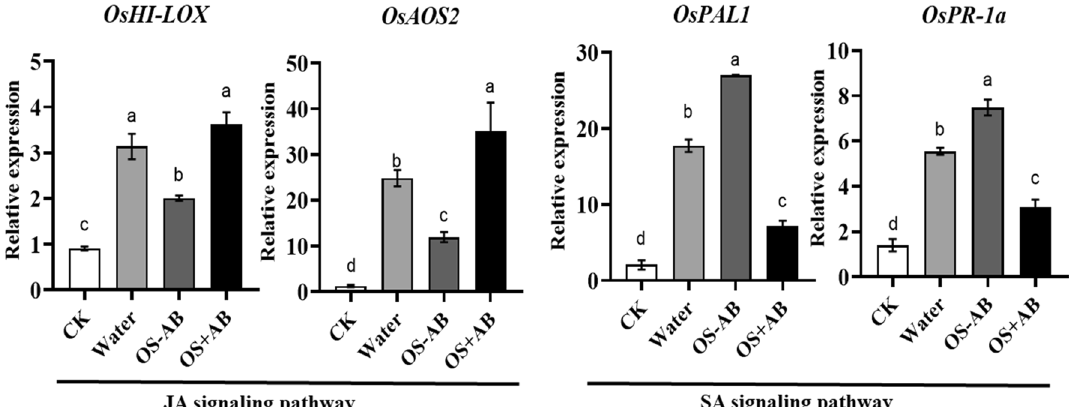
Fig. 4 Expression levels of JA and SA signaling pathway-related genes in rice plants damaged by oral secretion collected from AB-treated or untreated larvae. Gene expression was analyzed 24 h after treatment. Different letters above bars indicate statistically significant differences 39.44, P < 0.001; OsAOS2 , F (3,20) 19.78, P < 0.001; OsPAL1 , F (3,20) 332, between treatments (ANOVA, P < 0.05; followed by LSD test; OsHI-LOX , F (3,20) = = = P < 0.001; OsPR-1a , F (3,20) 85.85, P < 0.001; n 6). CK, untreated rice plants; Water, rice stems wounded and applied with sterilized water; OS-AB, rice = = stems wounded and treated with oral secretion collected from larvae without AB; OS